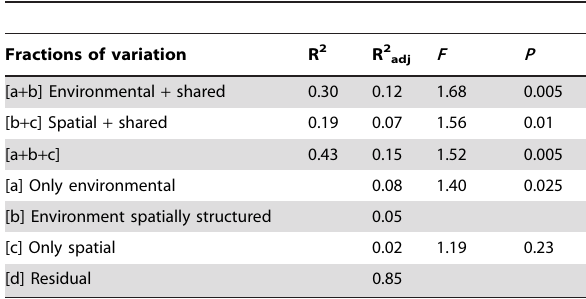
Table 3. Variation partitioning of environmental and spatial effects on web-spider metacommunity composition.